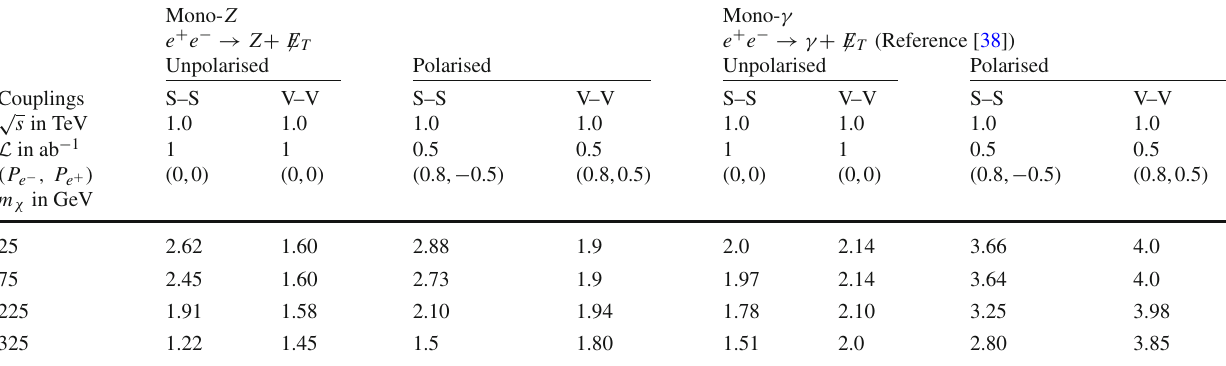
Table4 ComparisonoftheILCkinematicreachonthe Λ max . inTeVfor dimensional χ 2 analysis with δ sys = 1% and in columns IV and V four representative values of m χ from the mono- Z channel and mono- γ we give the corresponding values of Λ max for the mono-photon chan- channels corresponding to the scalar and vector interactions with the nel taken from [38]. The respective coupling of DM with the charged √ s = 1 TeV. In columns II unpolarised and polarised initial beams at and III we give the Λ max . for the hadronic channel based on our two-